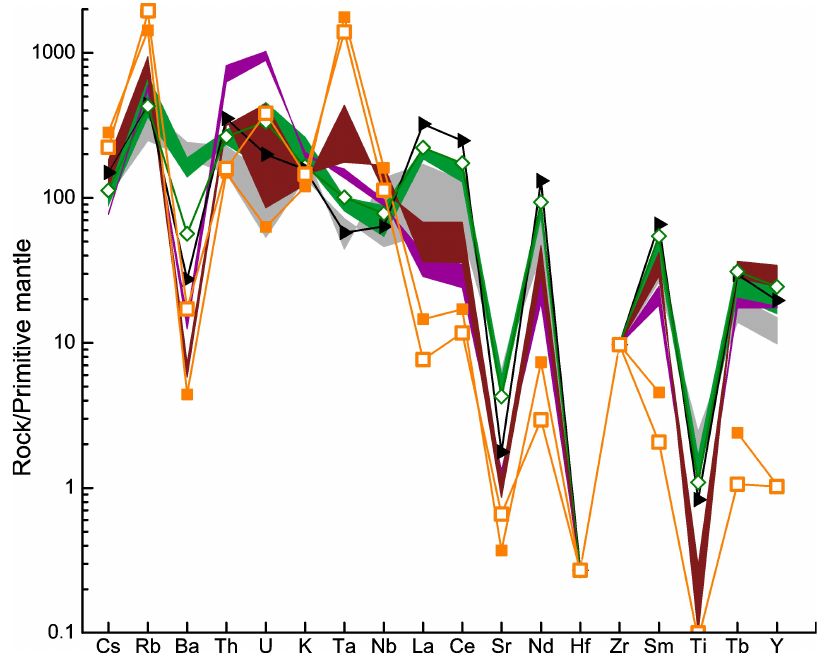
Figure 14. Trace elements of Salmi batholith rocks normalized to the primitive mantle [62]. Green field–field of granite porphyry, gray field–field of rapakivi granite, violet field–field of granite xenolites, and brown field–field of biotite granite. The legend is the same as that presented in Figure 9.